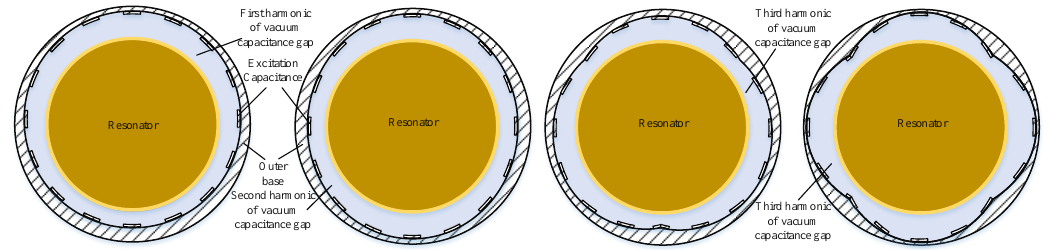
Figure 2. The structure diagram of first four harmonics of the uneven excitation capacitance gap.